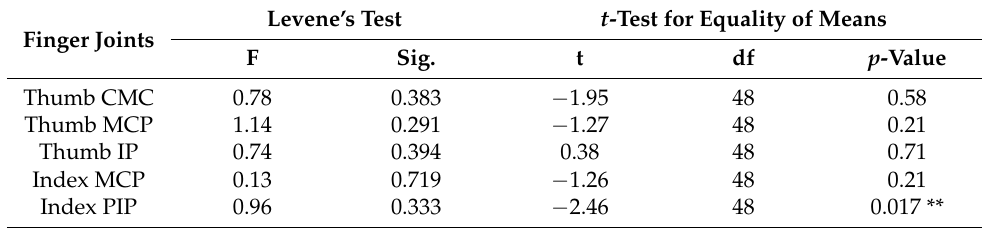
Table 4. Independent samples t -test for comparison flexion angles with respect to Test 12 and Test 14.